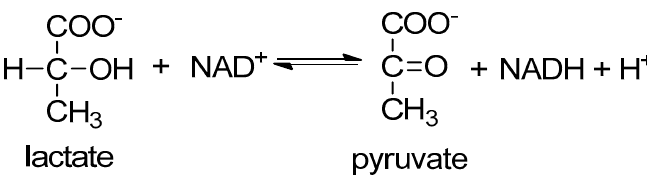
Figure 4. Fluorescent strategy to detect lactate with lactate dehydrogenase (LDH).